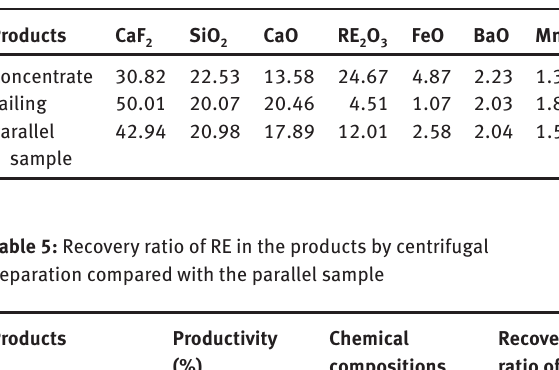
Table 4: XRF result of the separation products (mass fraction, %) Products Tailing